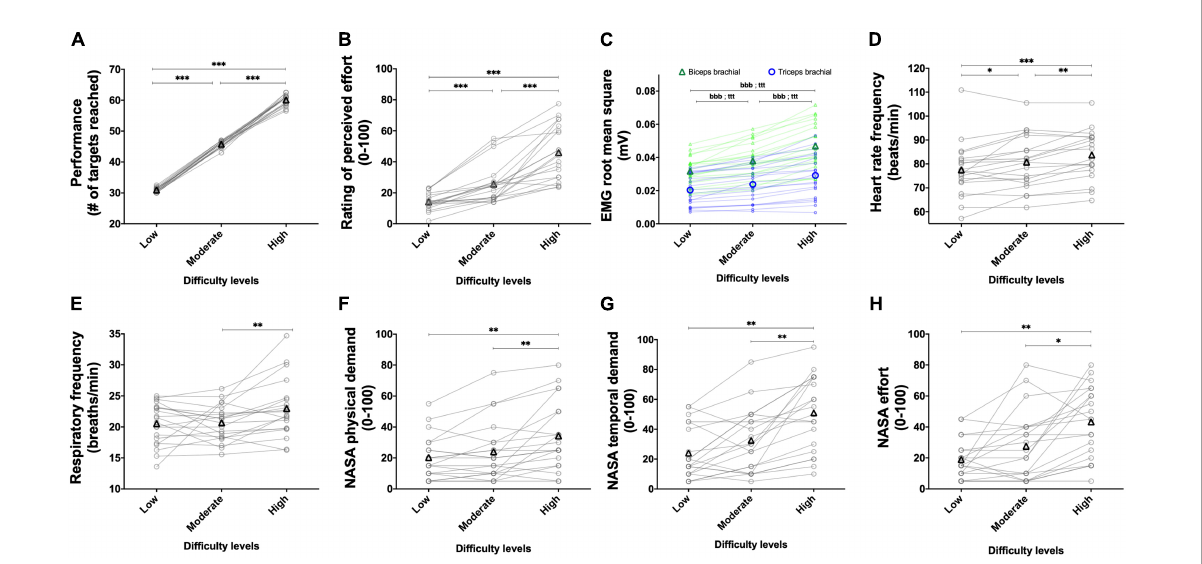
FIGURE6 Experiment 1B: Manipulating the tempo to alter task difficulty during the pointing task. Effect of manipulating the tempo during the pointing task on performance ( A , n = 20), rating of perceived effort ( B , n = 20), EMG root mean square of the biceps (green line) and triceps (blue line) brachial muscles ( C , n = 20), heart rate frequency ( D , n = 18), respiratory frequency ( E , n = 20) and NASA TLX scores for physical demand ( F , n = 20), temporal demand ( G , n = 20) and subjective effort ( H , n = 20). For the low difficulty, a 1 Hz tempo was imposed. For the moderate difficulty, a 1.5 Hz tempo was imposed. For the high difficulty, a 2 Hz tempo was imposed. Data are presented as the main effect of difficulty, except for panel C presenting the difficulty × muscle interaction. The n indicates the number of participants with all the data in each of the three levels of difficulties. Changes in the n reflect data loss due to issues with equipment or movement artifact. Individual data are presented in light markers and means in dark markers. *Main effect of difficulty, the difference between two difficulty levels. b and t difference between two difficulty levels for the biceps and triceps brachial muscles, respectively. One symbol: p < 0.05, two symbols: p < 0.01, and three symbols: p <